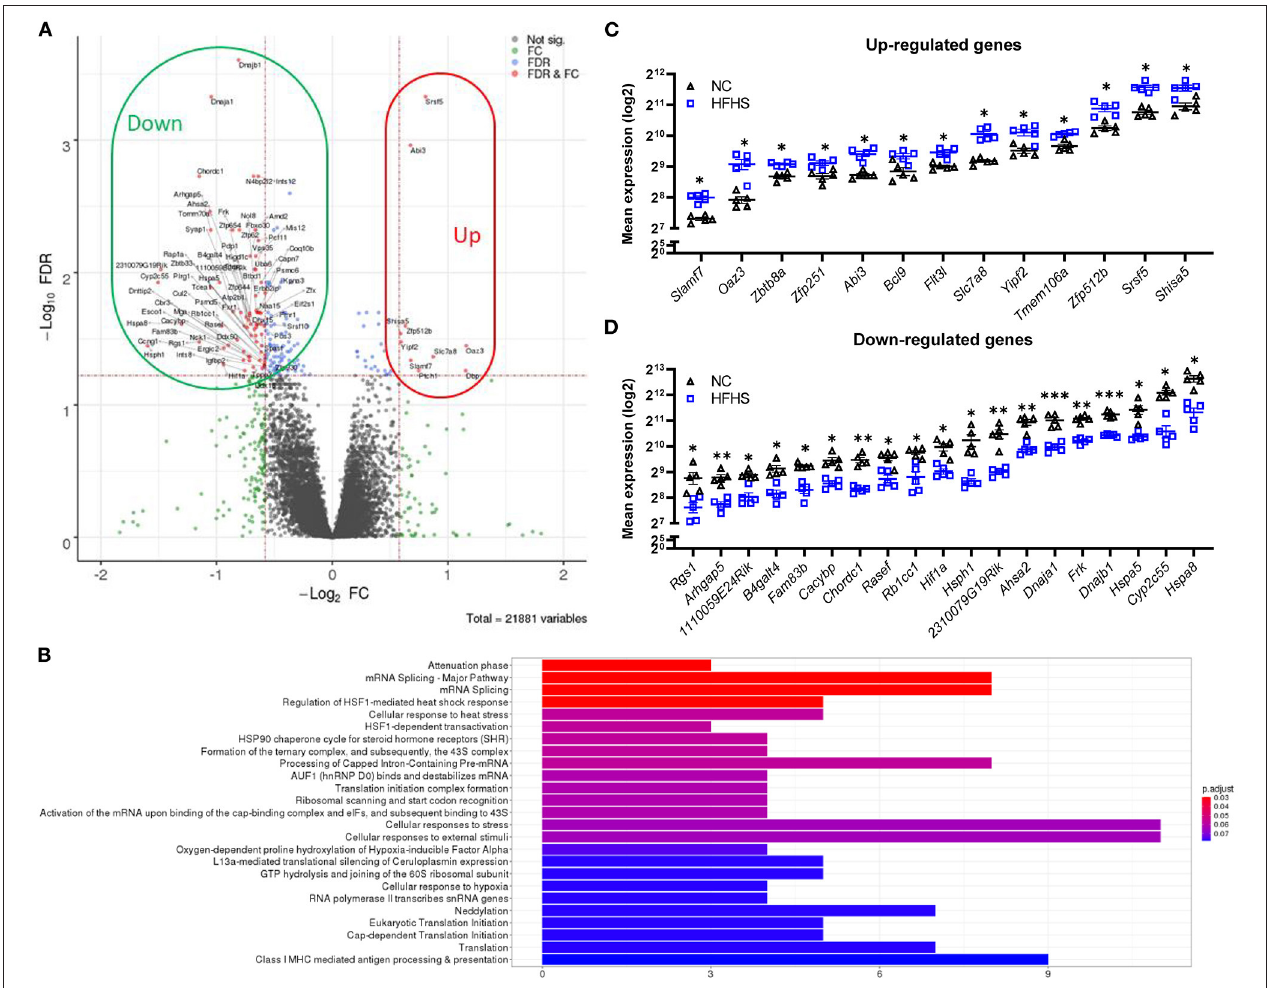
FIGURE 3 | High-fat high-sucrose diet triggers multiple cellular stress responses on the colonic transcriptome. (A) Volcano plot and (B) Top Reactome pathways of dysregulated genes for HFHS-fed mice ( N = 5) vs. NC-fed ( N = 5). Statistical analyses identified 154 differentially expressed genes, 86% (132) being under-expressed in HFHS-fed compared to NC-fed mice (FDR < 0.05; fold change > 30%). (C, D) Top dysregulated genes in mice fed a HFHS diet compared with NC diet. Mean expression values (log2) are plotted with standard deviations for up- and down-regulated genes. FDR * ≤ 0.05, ** < 0.01, *** <